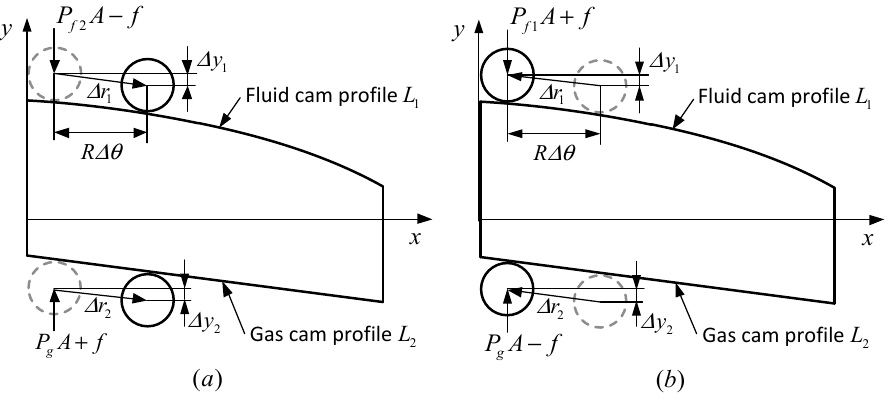
Figure 4. Model of the cam mechanism in 2D: ( a ) charging process; ( b ) discharging process. The pressure 2 f P is larger than the pressure 1 f P because of the piston friction. The fluid